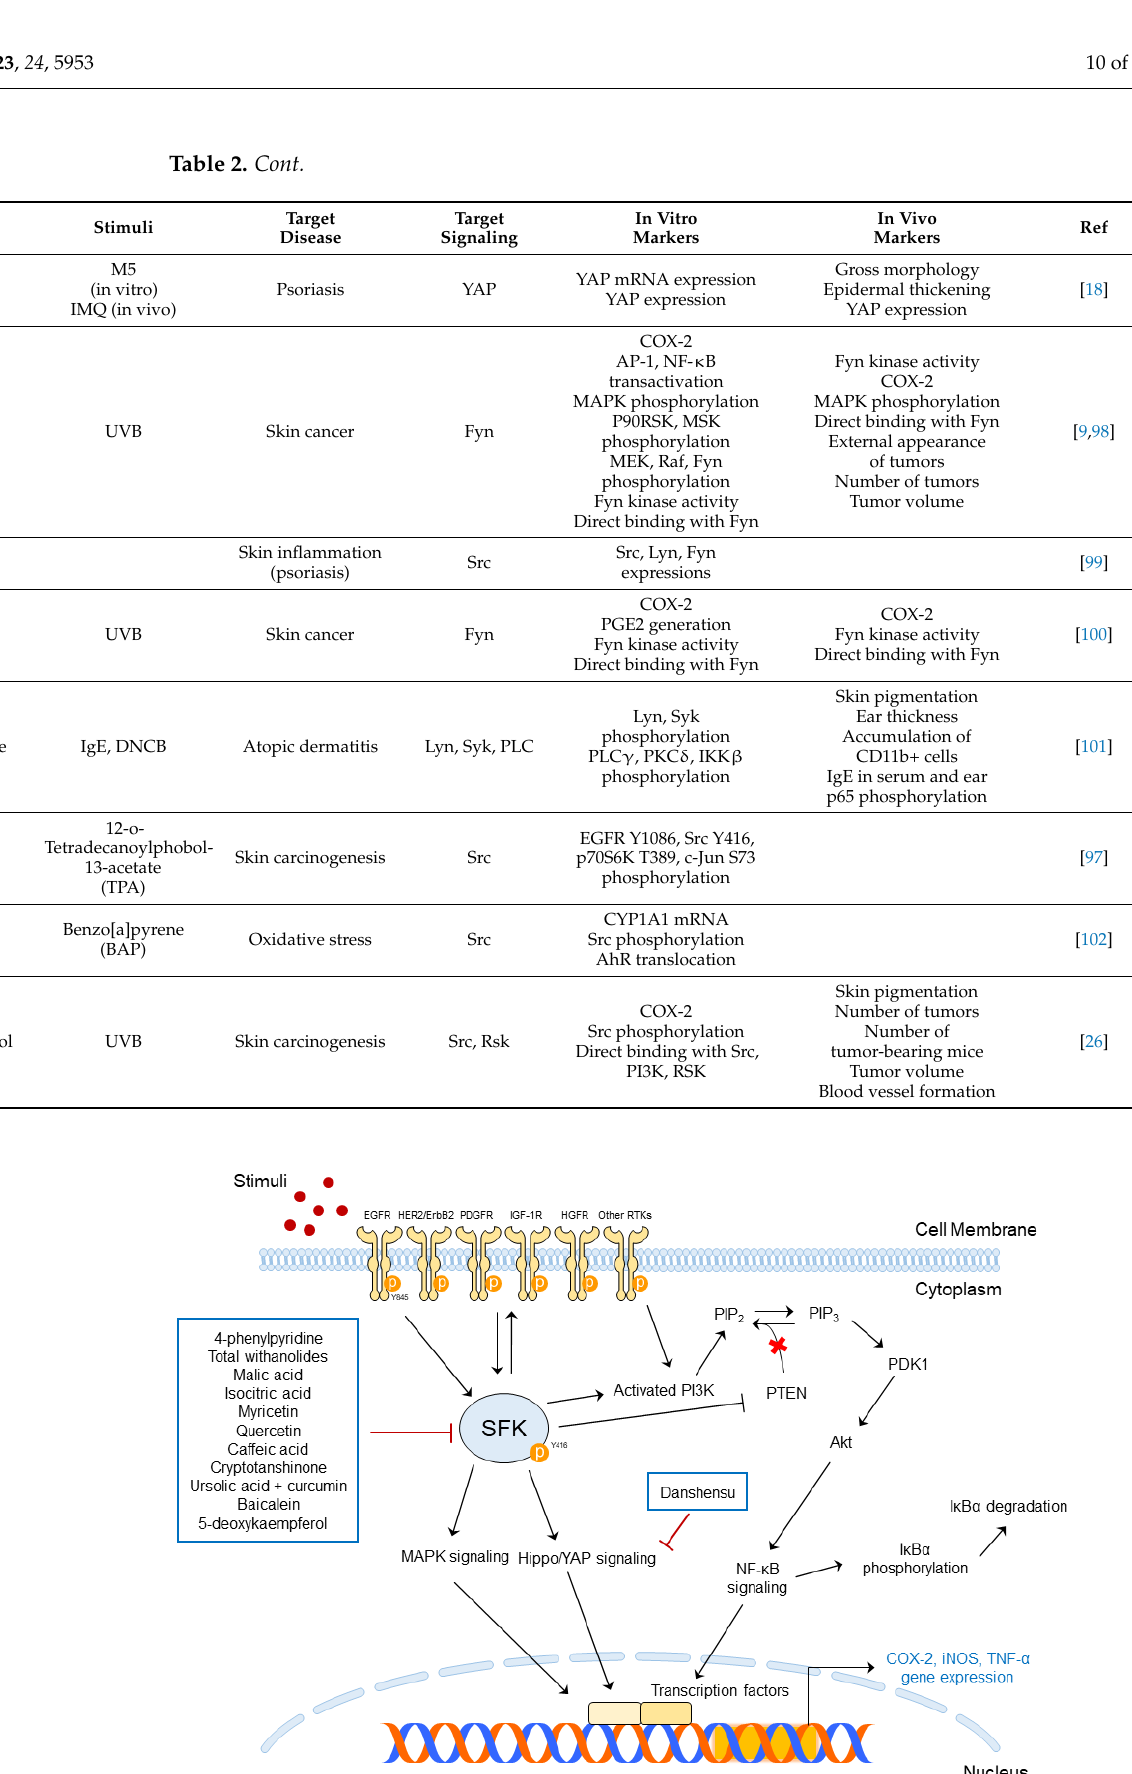
Figure 4. Regulation of SFK signaling pathways by phytochemicals in skin diseases. 4 - Phenylpyridine (4 - PP) suppressed skin inflammation caused by UVB by targeting c - Src in pre - clinical studies. 4 - PP decreased inflammation markers, such as COX - 2, AP - 1, and PGE 2 expression, by blocking c - Src - mediated MAPK phosphorylation in human im- mortalized cell lines. 4 - PP reduced epidermal thickness increased by UVB exposure and blocked COX - 2 expression, resulting in the phosphorylation of EGFR in UVB - irradiated mice [16]. Datura metel L. contains total withanolides; these phytochemicals can relieve psoria- sis - like skin inflammation induced via IMQ application. IMQ is a potent immune activator that stimulates Toll - like receptor (TLR)7/8; thus, it can exaggerate chronic inflammatory skin diseases such as psoriasis. Total withanolides restored IMQ - induced skin damage in male BALB/c mice through various pathways. Furthermore, the phosphorylation of STATs and MAPKs induced by cytokines was decreased, as well as the phosphorylation of Lck, Lyn, and Src [103]. Malic acid and isocitric acid improved wound healing by targeting c - Src. The phos- phorylation of Src Y416, EGFR (upstream of Src), and STAT3 Y705 (downstream of Src) was blocked by the treatment of malic acid and isocitric acid [67]. Danshensu inhibited abnormal epidermal proliferation through the yes - associated protein (YAP) pathway, resulting in improved psoriasis. Src has been proven to drive tu- mor development and metastasis through the activation of the YAP/PD - binding motif (TAZ) axis [104] and lead to the expression of COX - 2 [105]. Danshensu was found to sup- press M5 - induced cell apoptosis and regulate cell cycle - related factor expression in Ha- CaT cells. Furthermore, it decreased YAP mRNA and protein expression in both HaCaT cells and BALB/c mice. Myricetin inhibited UVB - induced skin carcinogenesis by targeting Fyn kinase. It reg- ulated Fyn downstream pathways and bound directly to Fyn to block Fyn kinase activity in JB6P+ mouse skin epidermal cells [9,98]. Quercetin exists in many natural plants and is a phyto - compound that downregu- lates Src expression levels in human keratinocytes. Thus, psoriasis, which frequently oc- curs along with skin inflammation, can be alleviated by the action of quercetin [99]. Caffeic acid generally found in coffee blocks elevated Fyn activity. Caffeic acid also decreased COX - 2 expression and its promoter activity by directly binding with Fyn ki- nase. Therefore, caffeic acid can prevent UVB - induced skin carcinogenesis [100].